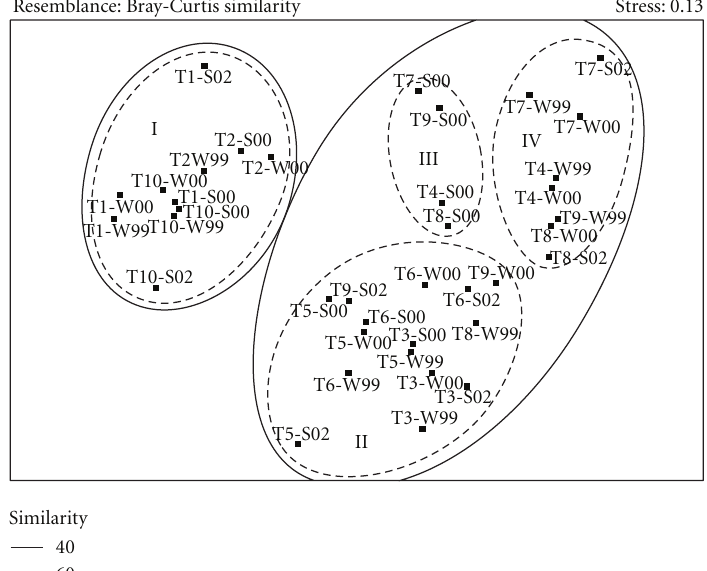
Figure 3: MDS ordination of the reef flat stations based on species cover; T1–T10 = sites one to ten; W99 = winter 1999, W00 = winter 2000, S00 = summer 2000, S02 = summer